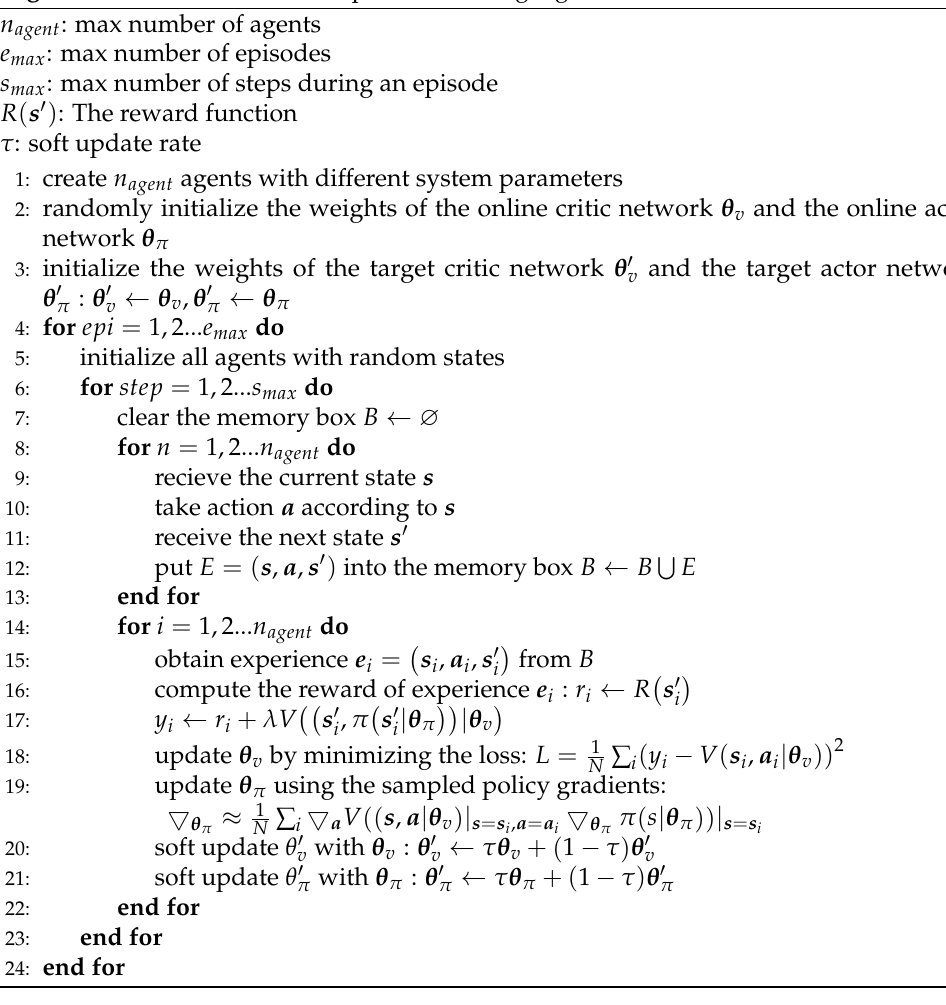
Algorithm 1 Extended-state RL parallel training